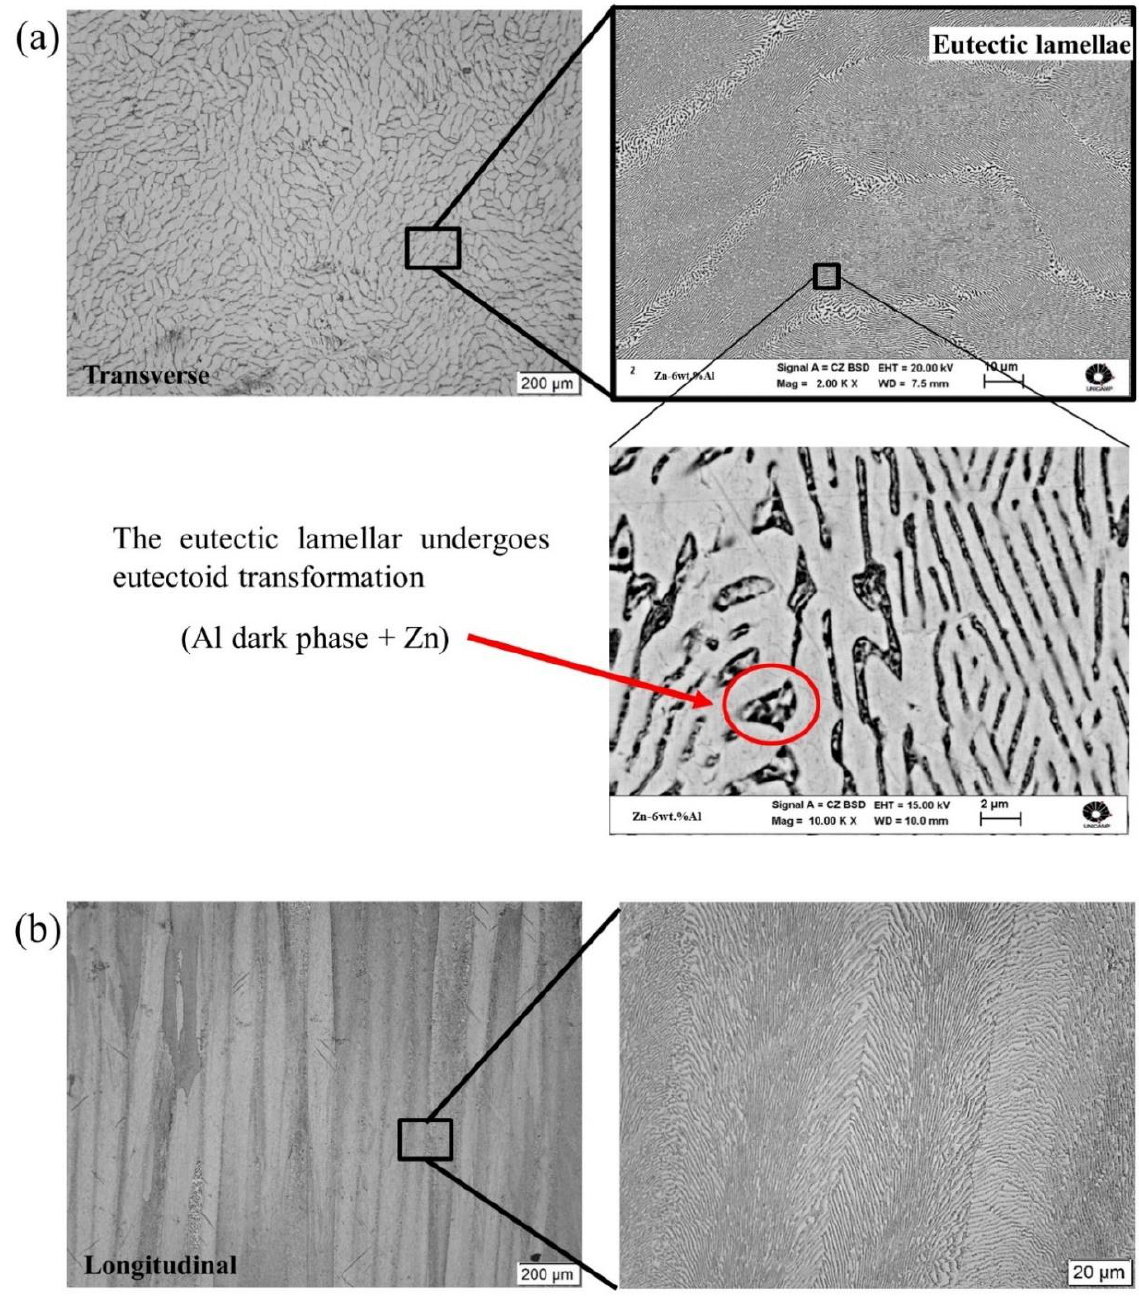
Figure 10. Typical microstructure of the Zn – 6wt.% Al alloy highlighting a eutectic lamella in ( a ) transverse and ( b ) longitudinal sections of the DS casting. The sample was extracted at 10 mm from the cooled bottom of the casting.